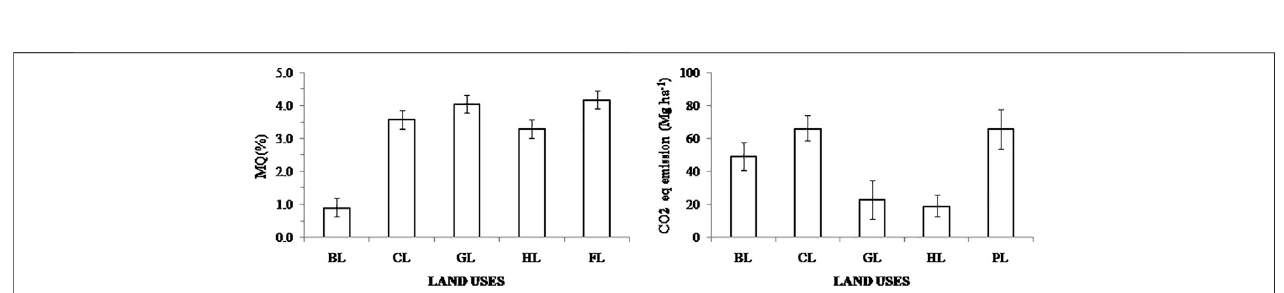
FIGURE 7 | Comparison of microbial quotient (MQ) and CO 2 eq. emissions in various land uses from the collected studies (mean ± standard error). Here, Forest land (FL) is used as control, BL — Barren land, CL — Cultivated land, GL — Grassland, HL — Horticulture land, and PL — Plantation land. Note: PL has no suf fi cient data for MQ